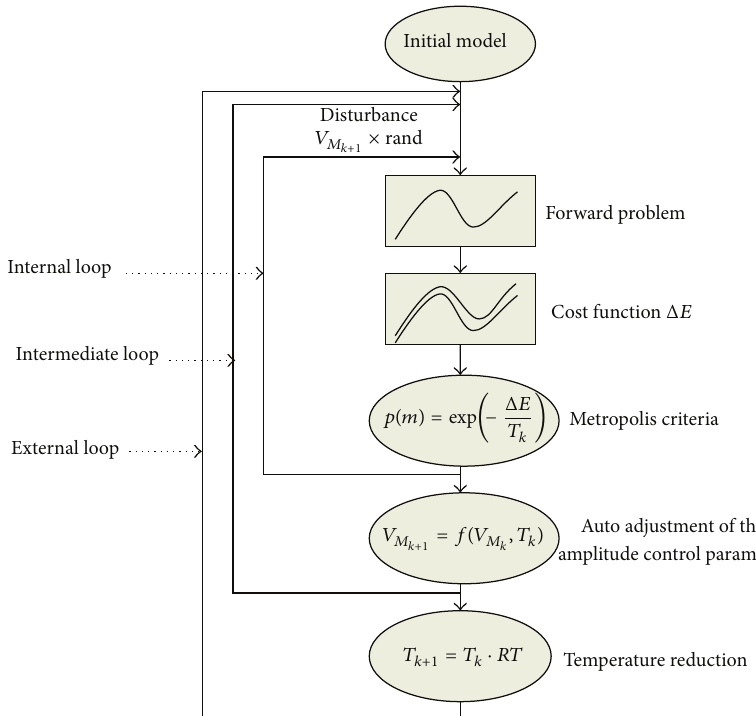
Figure 10: Flux diagram representation of the simulated annealing algorithm applied in this work (modified from Ortiz-Alem´an and Martin [15]).